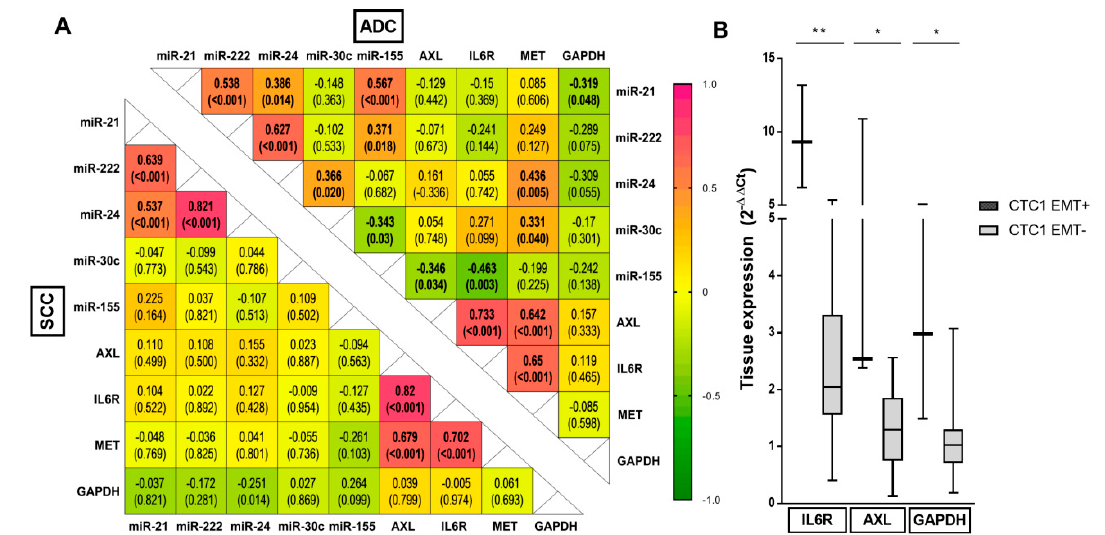
Figure 2. Genetic and miRNA tissue profiling and CTC correlation in ADC: ( A ): Heat-map correlation between selected miRNAs and genes in ADC (top-right corner) and in SCC (bottom-left corner). Data represent Spearman’s rho and ( p -value). p < 0.05 in bold. Pink tones show positive correlations, yellow neutral, and green tones show negative correlations. ( B ): Blox-plot of gene tissue expression relationship with CTC phenotypes in ADC. Pattern fill colors represent the presence of CTC versus plain colors showing absence. Mann–Whitney U-test. * p < 0.05, ** p < 0.01.